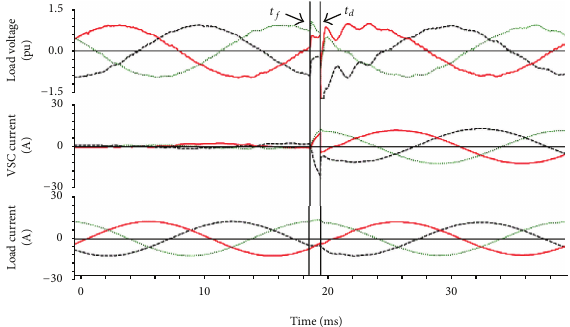
Figure 11: Simulation results of VSS with single phase.